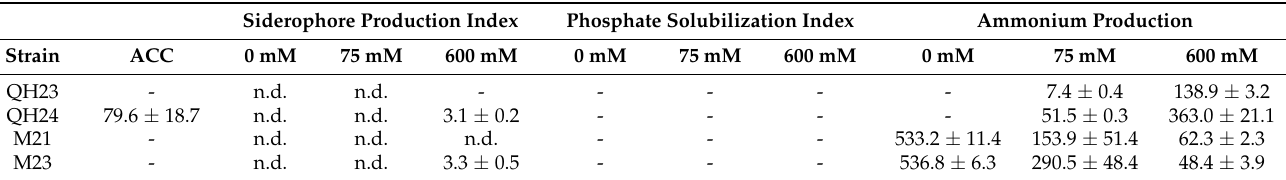
Table 5. PGP features.